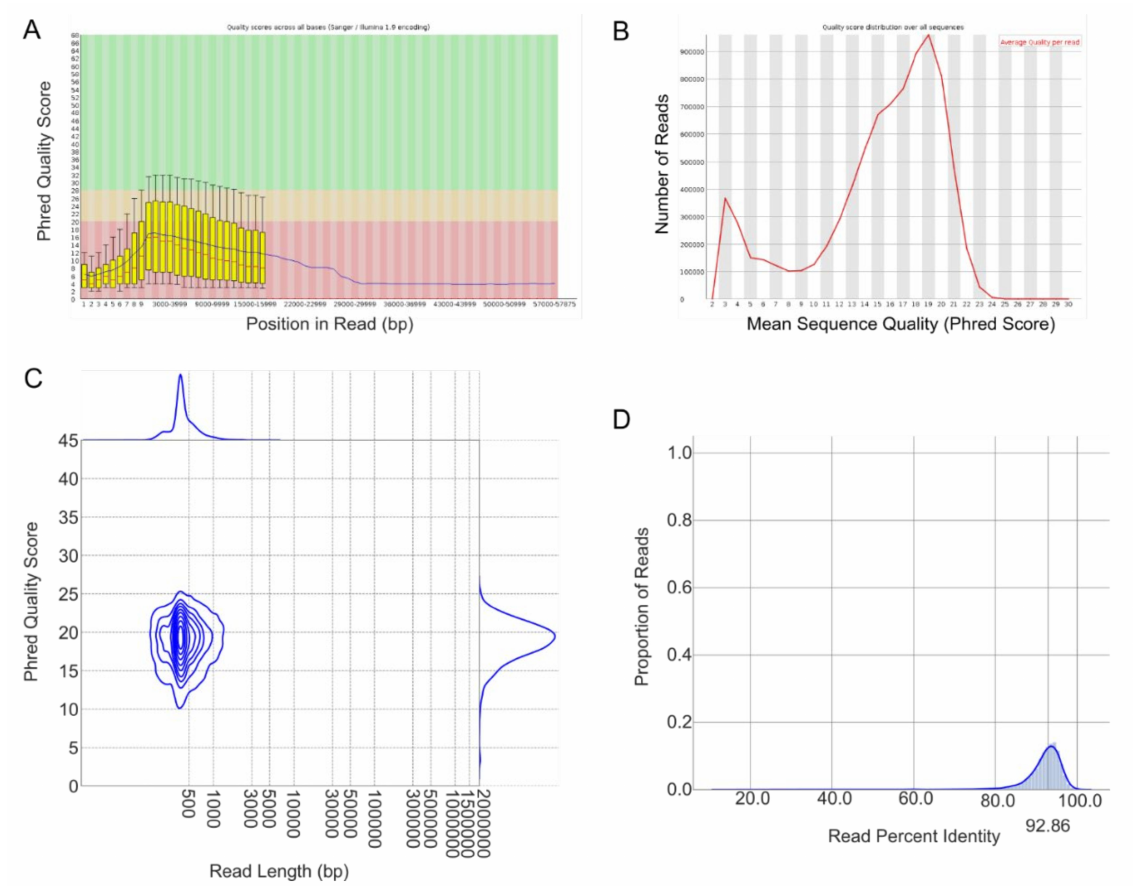
Figure 6. L-RAPiT provides detailed quality-control metrics before and after alignment. ( A , B ) Se- lected output from FastQC for the unprocessed, unaligned reads of use-case sample SRR12389274. ( A ) Box plot showing the average Phred score and its spread for ranges of nucleotide position within reads. ( B ) Graph of the average Phred score per read and corresponding frequency. ( C , D ) Selected output from Pistis for the use-case sample after Shark filtering and minimap2 alignment. ( C ) Density plot of read length vs. the average Phred score per read, as well as the associated distributions. ( D ) Read alignment percent identity and the proportion of reads with that